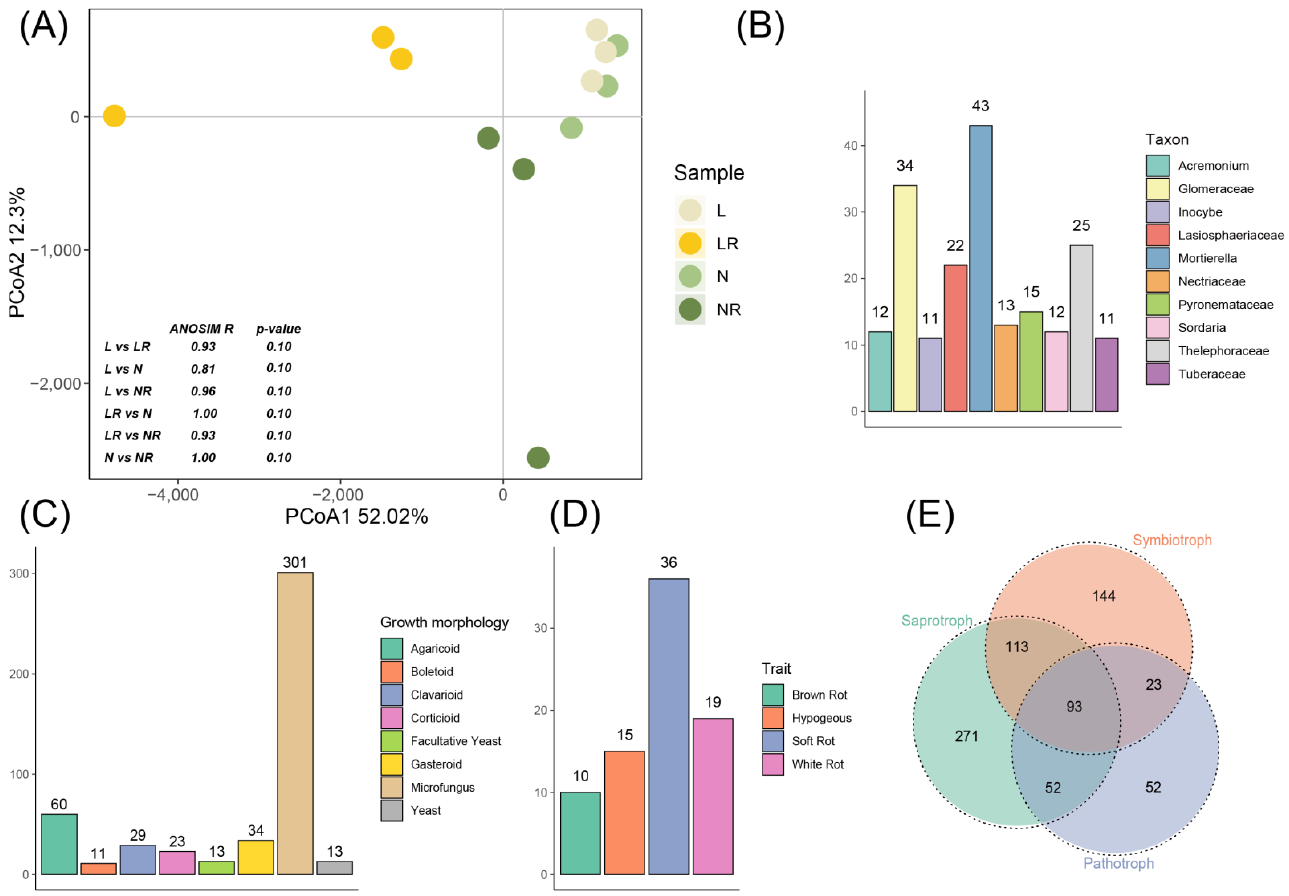
Figure 7. Prediction of function of soil fungi associated with normal-growth and limited-growth highbush blueberry plants. LR-rhizosphere soil of plants with limited growth; N-bulk soil of normally growing plants; L-bulk soil of plants with limited growth. ( A ) Principal co-ordinates analysis of predicted gene function of fungi. ( B ) Predicted distribution of the fungal taxa. NR-rhizosphere soil of normally growing plants. ( C ) Predicted fungal growth morphology. ( D ) Predicted fungal phenotypes regarding decomposition of carbon-containing compounds. ( E ) Venn diagram of the main nutritional mode of fungi.